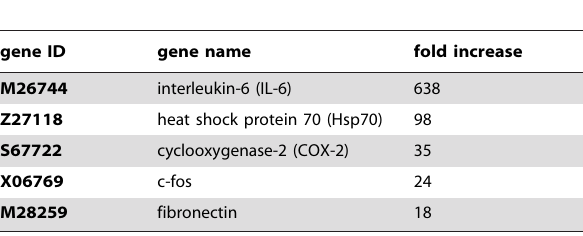
Table 1. A list of top 5 genes upregulated in astrocytes by MeHg (10 m M, 2